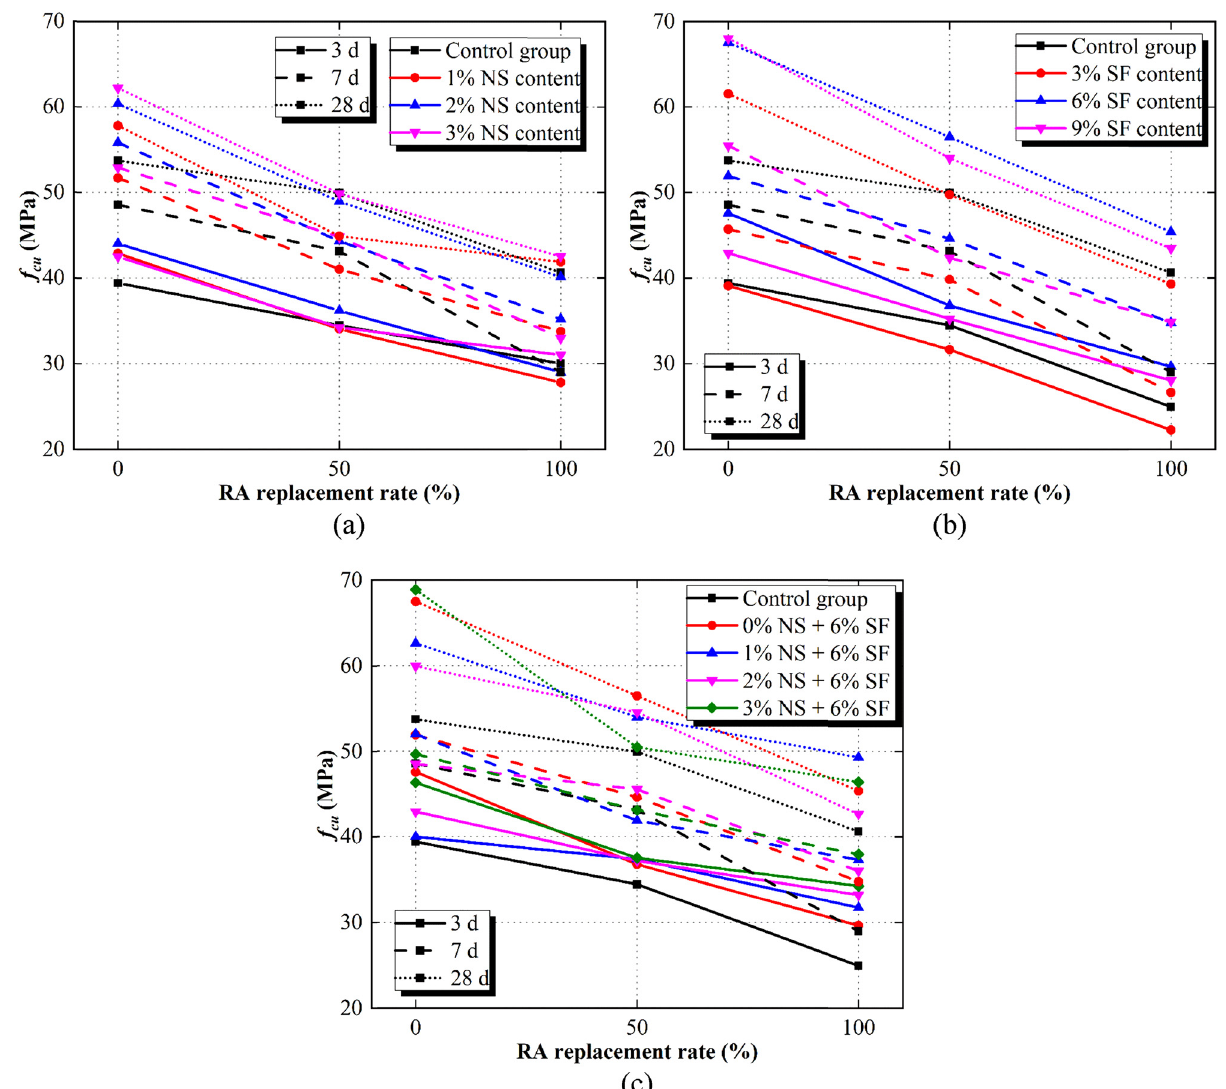
Figure 7: E ff ect of RA replacement percentages on the cubic compressive strength of ( a ) NSRAC, ( b ) SFRAC, and ( c )